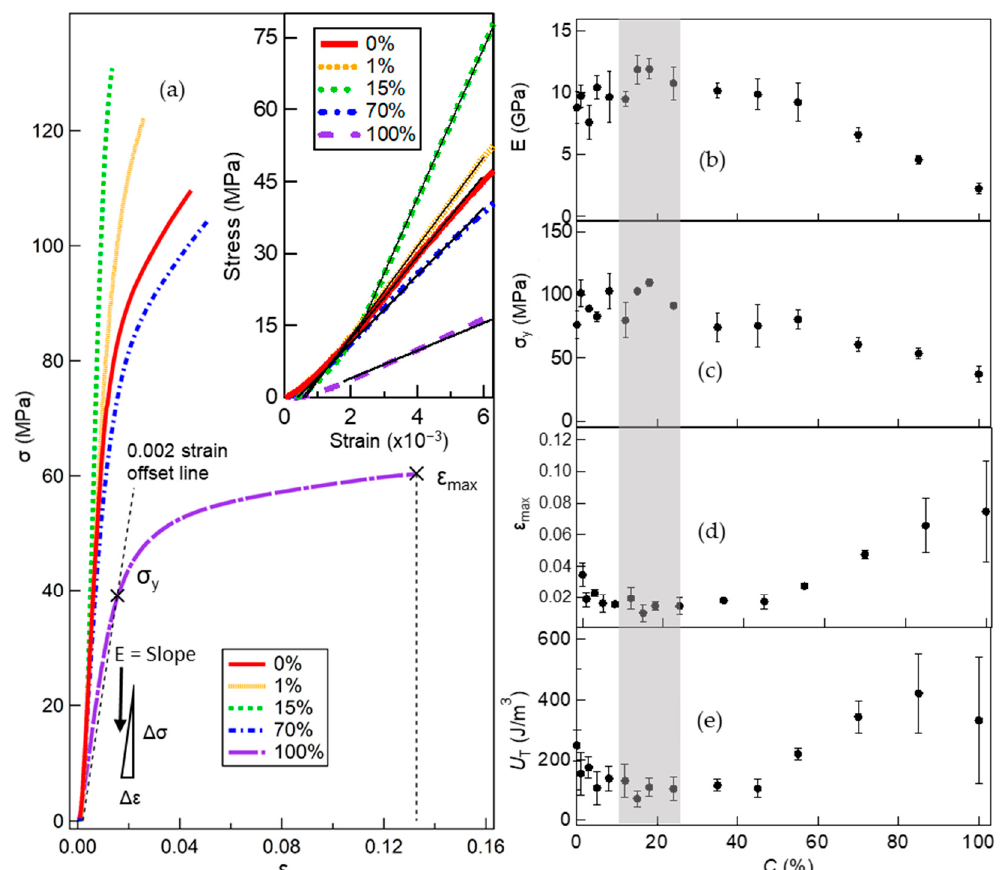
Figure 4. ( a ) Stress–strain curves to the point of fracture for selected specimens with various amorphous cellulose contents. The inset shows the elastic deformation at small strains, with linear fitting (thin lines through symbols) yielding the Young’s modulus. Mechanical properties of specimens obtained from the stress–strain curves, ( b ) Young’s modulus, ( c ) yield strength, ( d ) elongation at break, and ( e ) toughness, as a function of amorphous composition. A grey zone in ( b – e ) at ~20% AC indicates the modulus and yield strength at a maximum, and the elongation at break and toughness at a minimum.